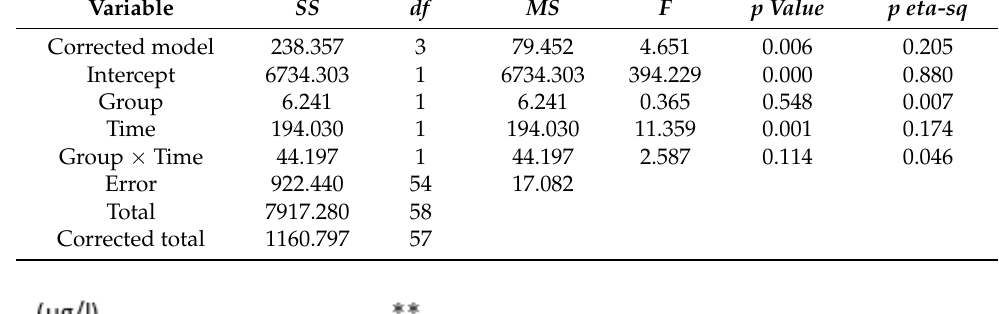
Table 5. Results of two-way ANOVA analysis of ALP.